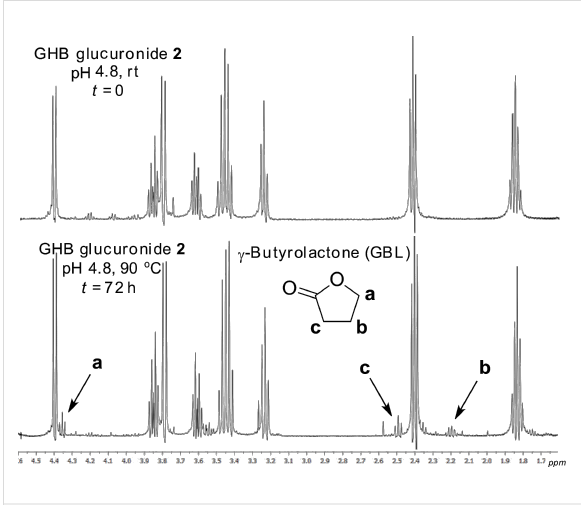
Figure 3: 1 H NMR spectra (500 MHz) of GHB glucuronide 2 in pH 4.8 buffer at t = 0 (rt) and t = 72 h (90 °C) by using a Watergate-type water suppression method (Supporting Information File 1). After heating at 90 °C for 72 h GBL starts to form at low concentration (indicated with